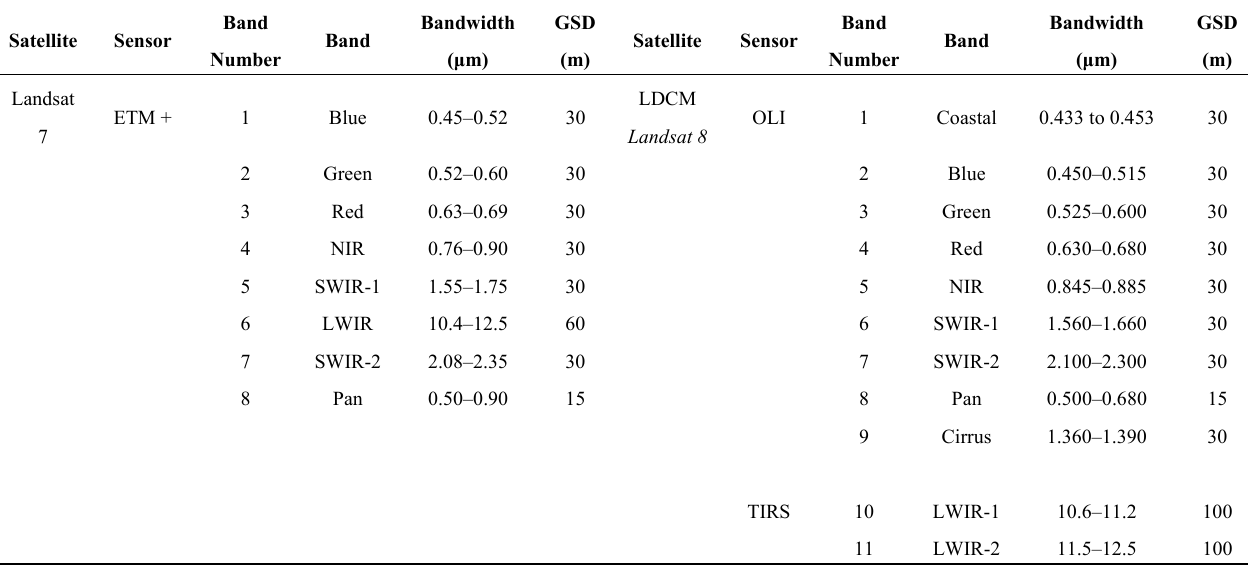
Table 1. Landsat 7 and Landsat Data Continuity Mission (LDCM) (Landsat 8) sensors, bandwidths and ground sample distance